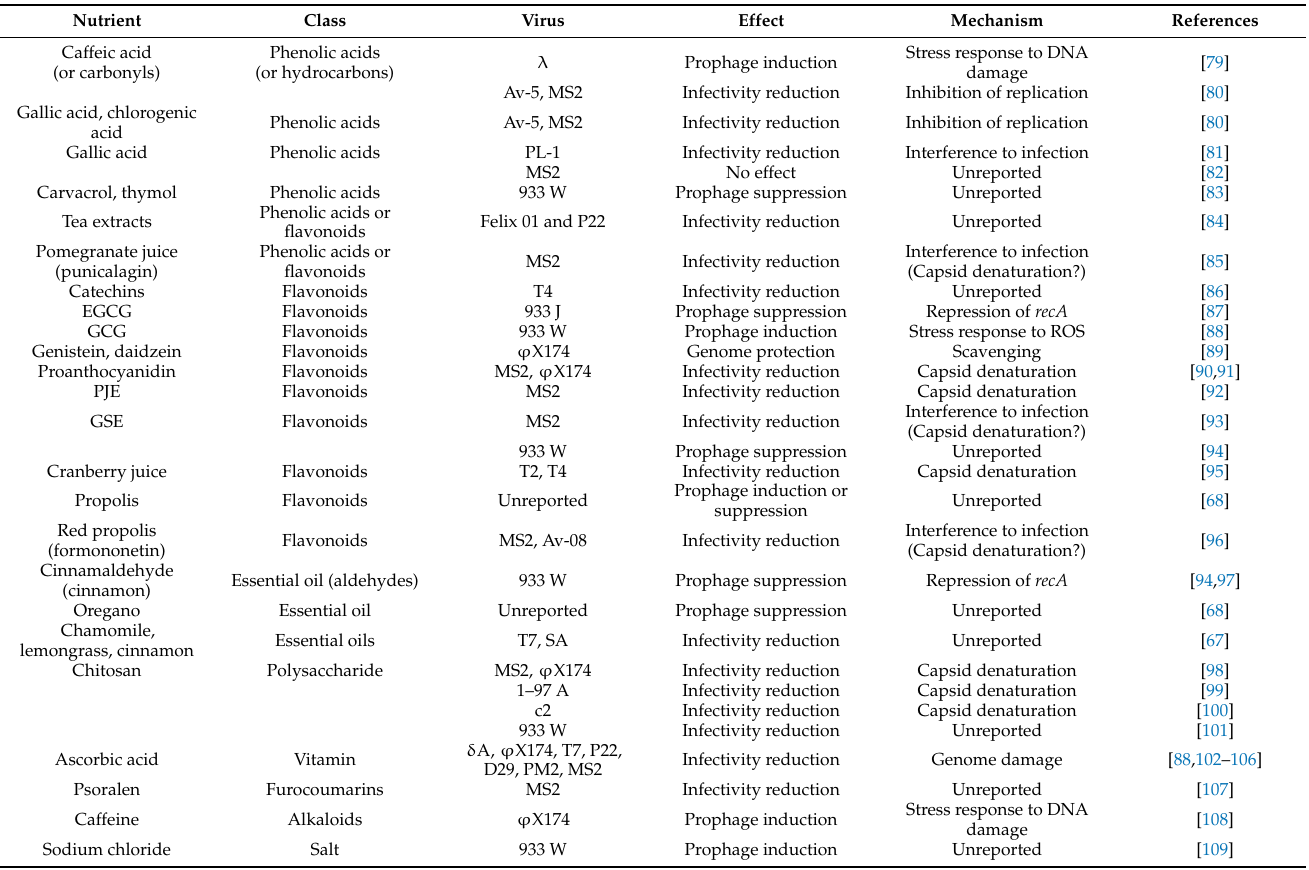
Figure 5. Chemical structures of the other active dietary compounds reported in the present review. Table 1. Effect of the dietary compounds reported in the present review, stratified by chemical class and viral target. The principle of action is also reported, as far as known so